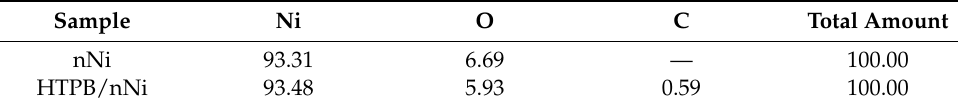
Table 1. EDS analysis results of nNi and